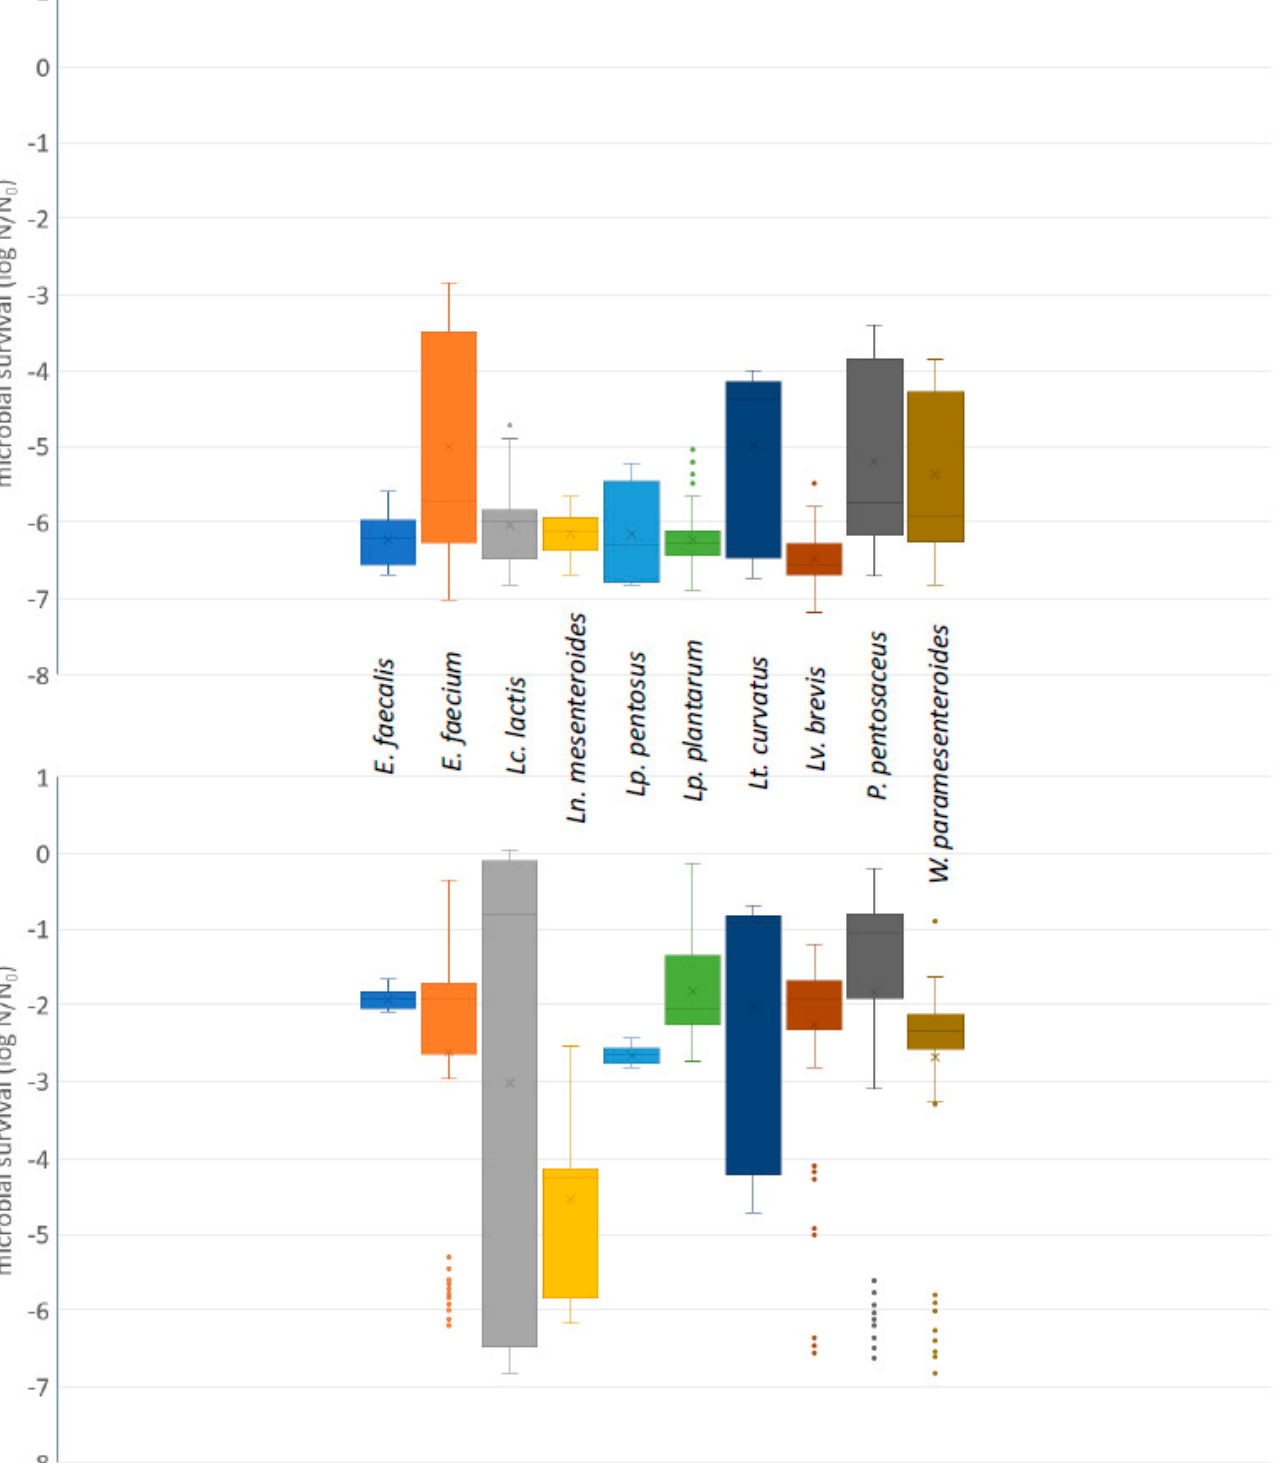
Figure 2. Box and whisker plot, summarizing the microbial survival (in log N/N 0 ) of the strains included in the present study, at species level after exposure to PBS buffer adjusted to pH 2 ( upper ) or 3 ( lower ) with HCl and incubation at 37 °C for 3 h. N: microbial population after incubation; N 0 : initial microbial population; solid circle symbol: outliers. Bile tolerance of the strains included in the present study is presented in Figure S2. A box and whisker plot, summarizing the survival of the strains after incubation, at